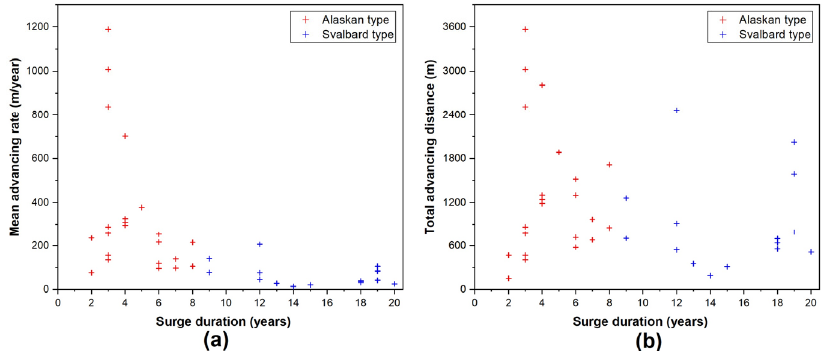
Figure 8. The magnitudes of terminus changes and surging ‐ duration years of the 38 clean ‐ ice or partly debris ‐ covered surge ‐ type glaciers in the Karakorum. ( a ) The mean advancing rate versus surge duration; ( b ) the total advancing distance versus surge duration.